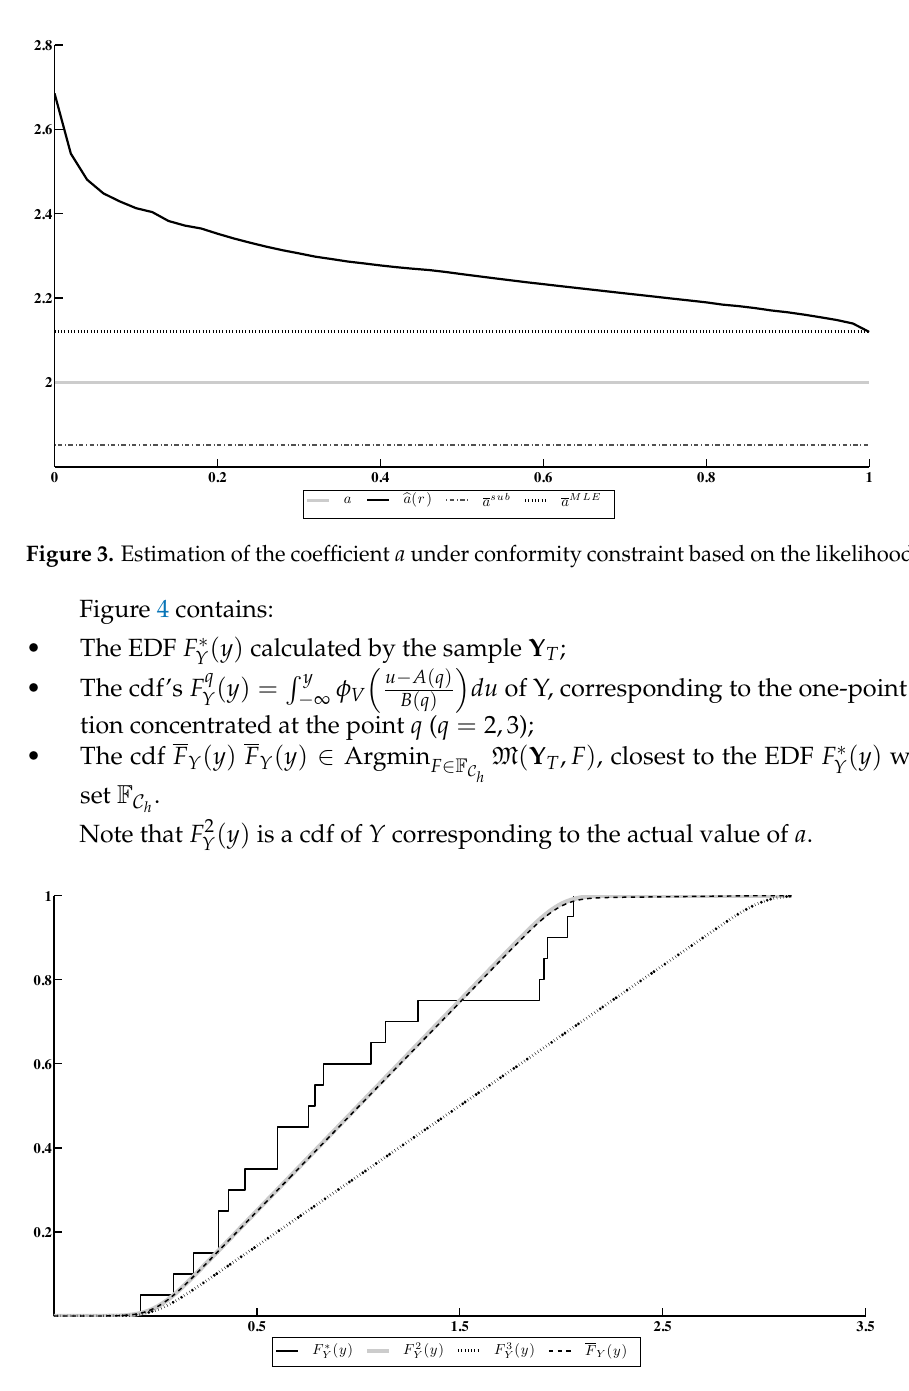
Figure 4. The EDF of Y and different cdf’s of Y under various choices of a . Figure 5 contains a comparison of the minimax estimate